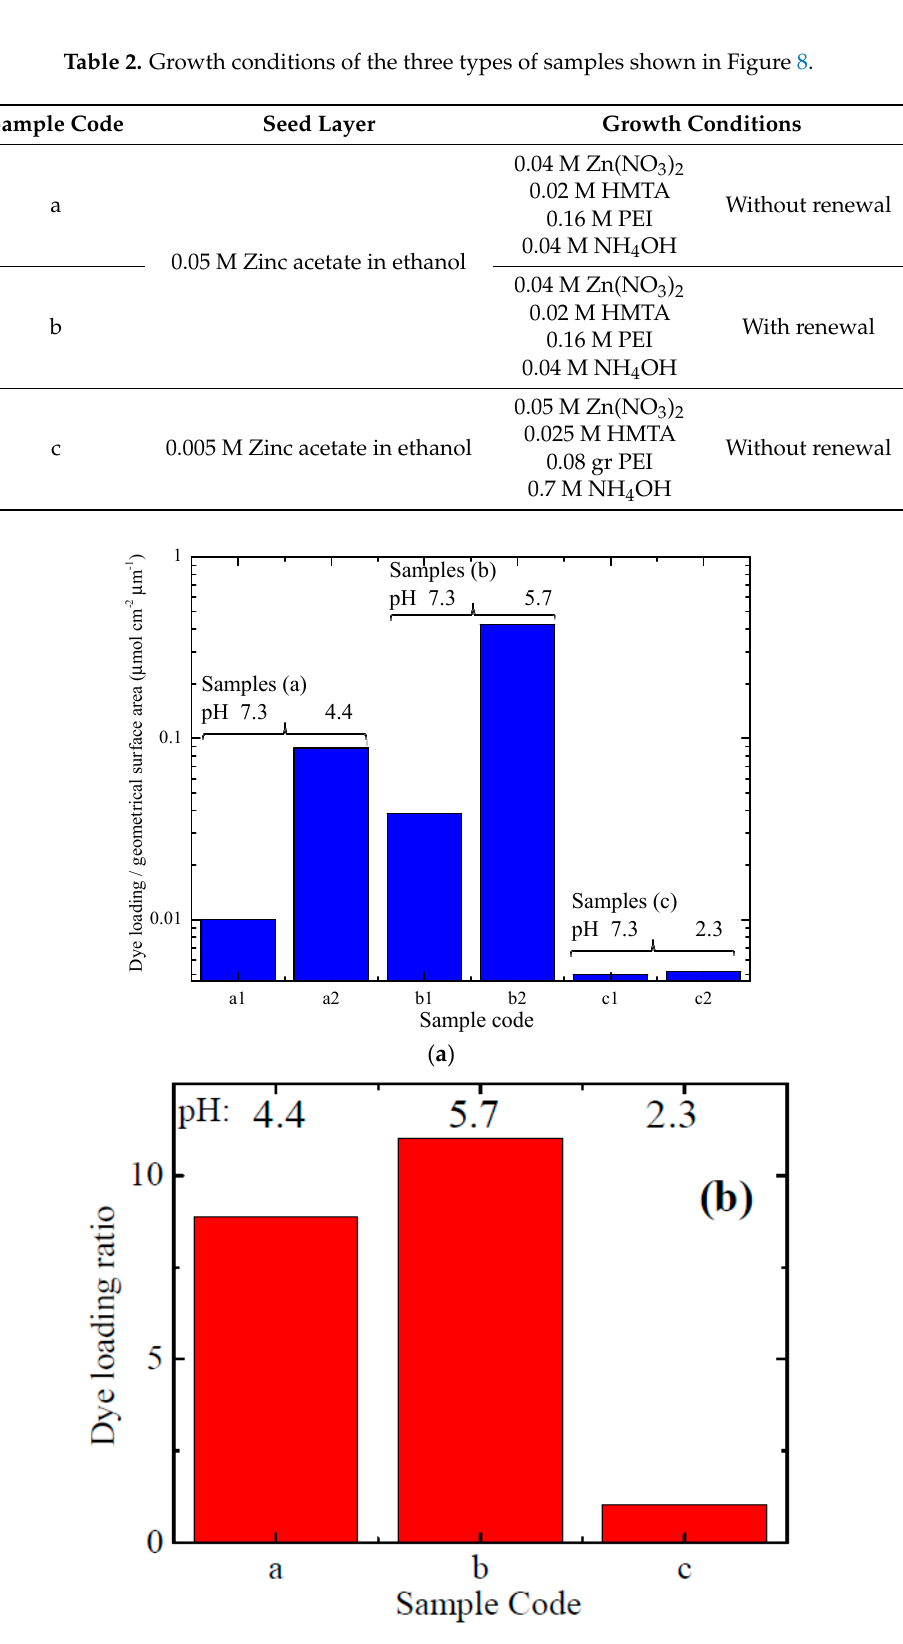
Figure 9. ( a ) Dye loading of NW arrays with the morphology shown in Figure 8. ( b ) Dye loading ratio of twin samples between the selected pH and the pH 7.3.